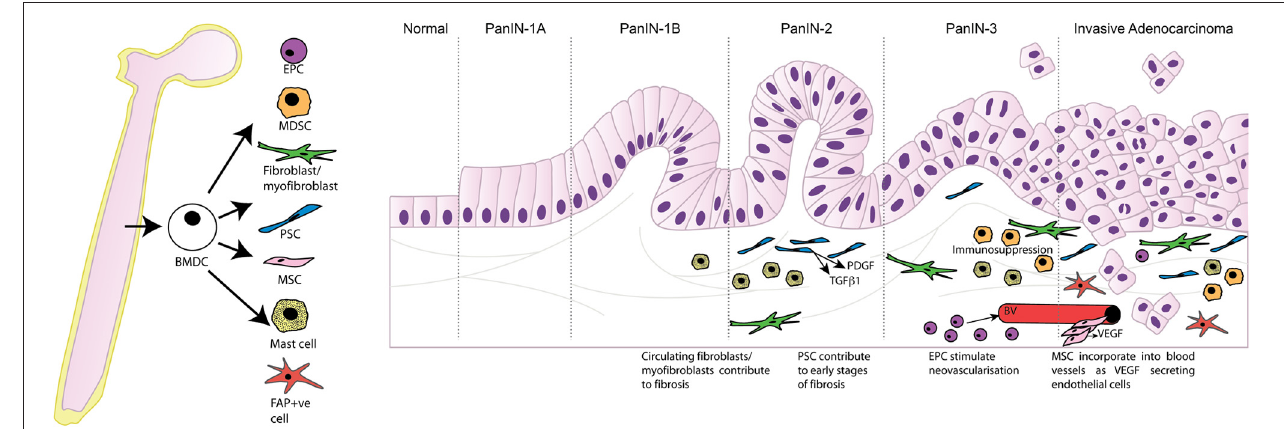
FIGURE 1 | Bone marrow derivedcellscontribute to the tumor microenvironmentfollowingrecruitmentto the desmoplasticstroma and differentiationinto multiplecell typespromoting tumor progression. PanIN,pancreaticintraepithelial neoplasia; BMDC, bonemarrow-derivedcells;